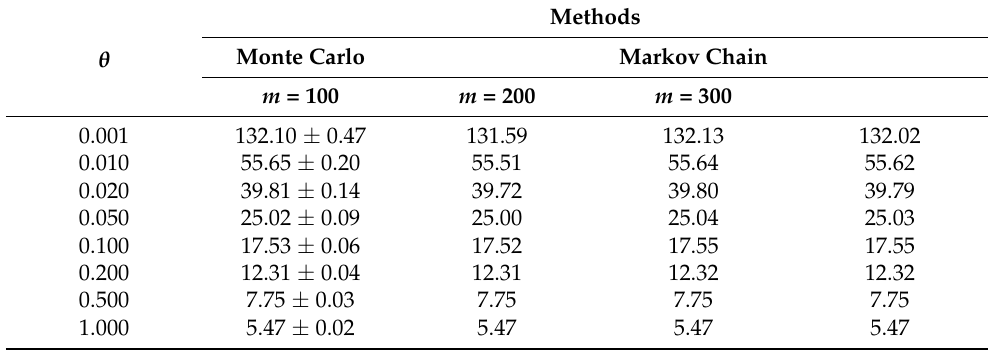
Table 1. Zero-state ARL values with different drift sizes when µ 0 = 4, λ = 0.05 and ARL 0 = 200.